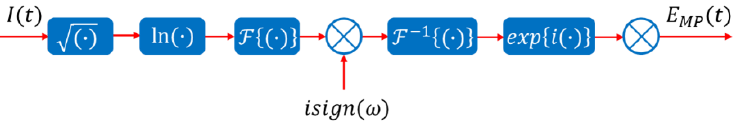
Figure 3. Signal processing of the KK receiver scheme.